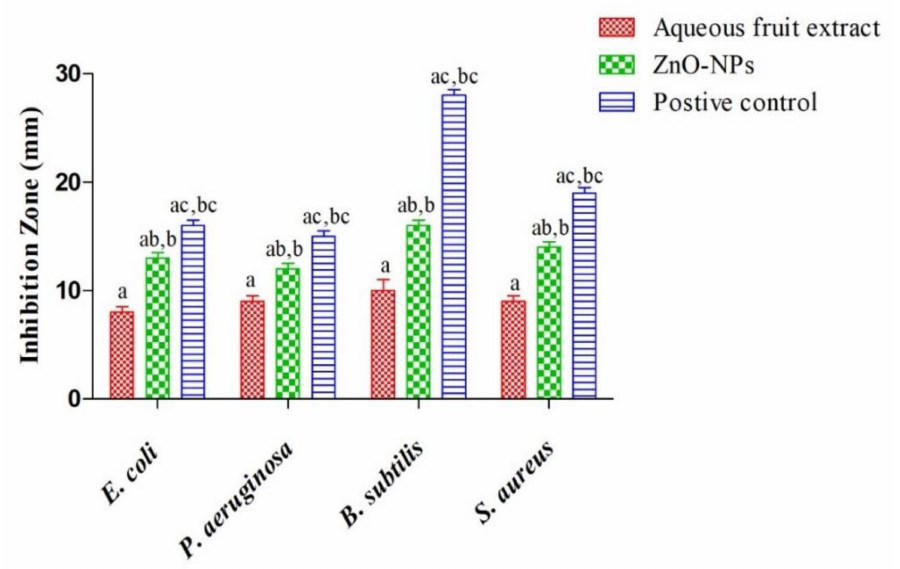
Figure 9. Antibacterial activity of aqueous extract and ZnO-NPs against pathogenic bacteria [Different superscript showed significant ( p < 0.05) difference between (a) fruit extract, (b) ZnO-NPs, and (c) positive control].